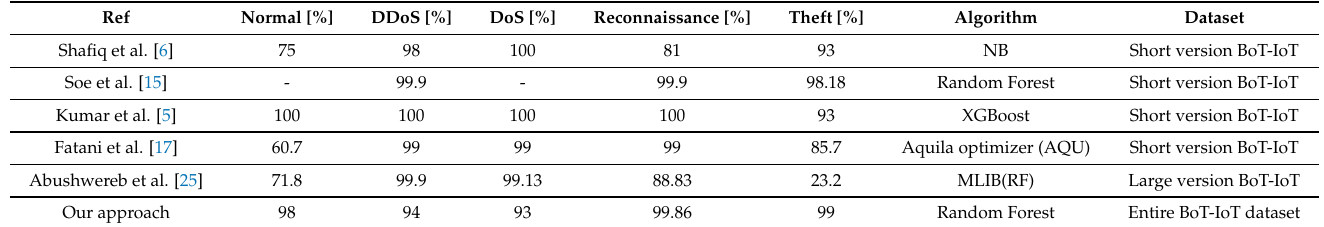
Table 2. Comparison of detection rate with other related